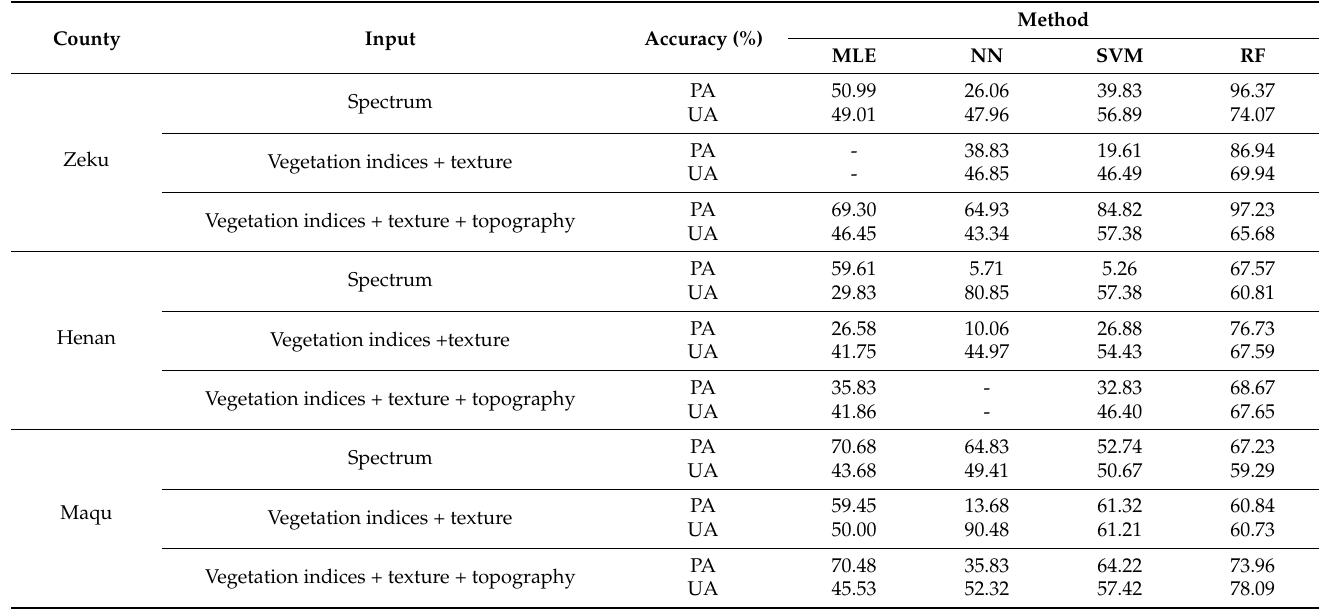
Table 5. Producer’s accuracy and user’s accuracy of Kobresia pygmaea community based on maximum likelihood estimate (MLE), neural network (NN), support vector machine (SVM) and random forest (RF) in Zeku, Henan and Maqu